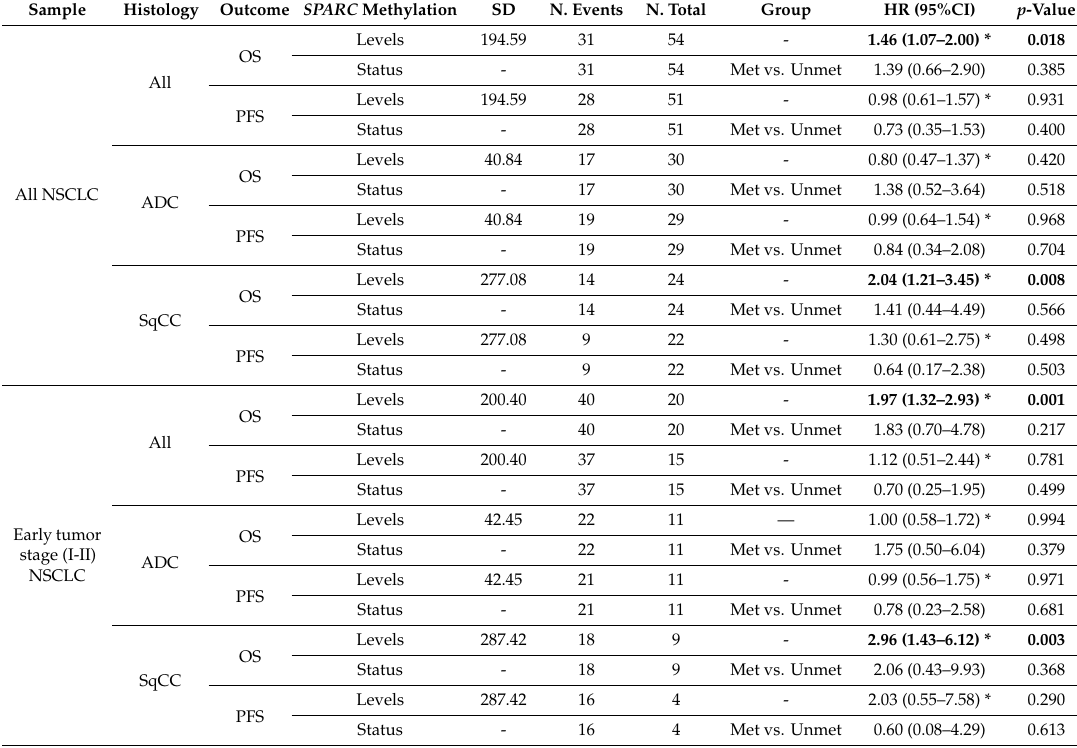
Table 4. Results from univariable Cox regression analysis that assess the association between SPARC methylation levels and status with overall survival and progression free survival in all NSCLC patients and within early stage tumor NSCLC patients and according to tumor